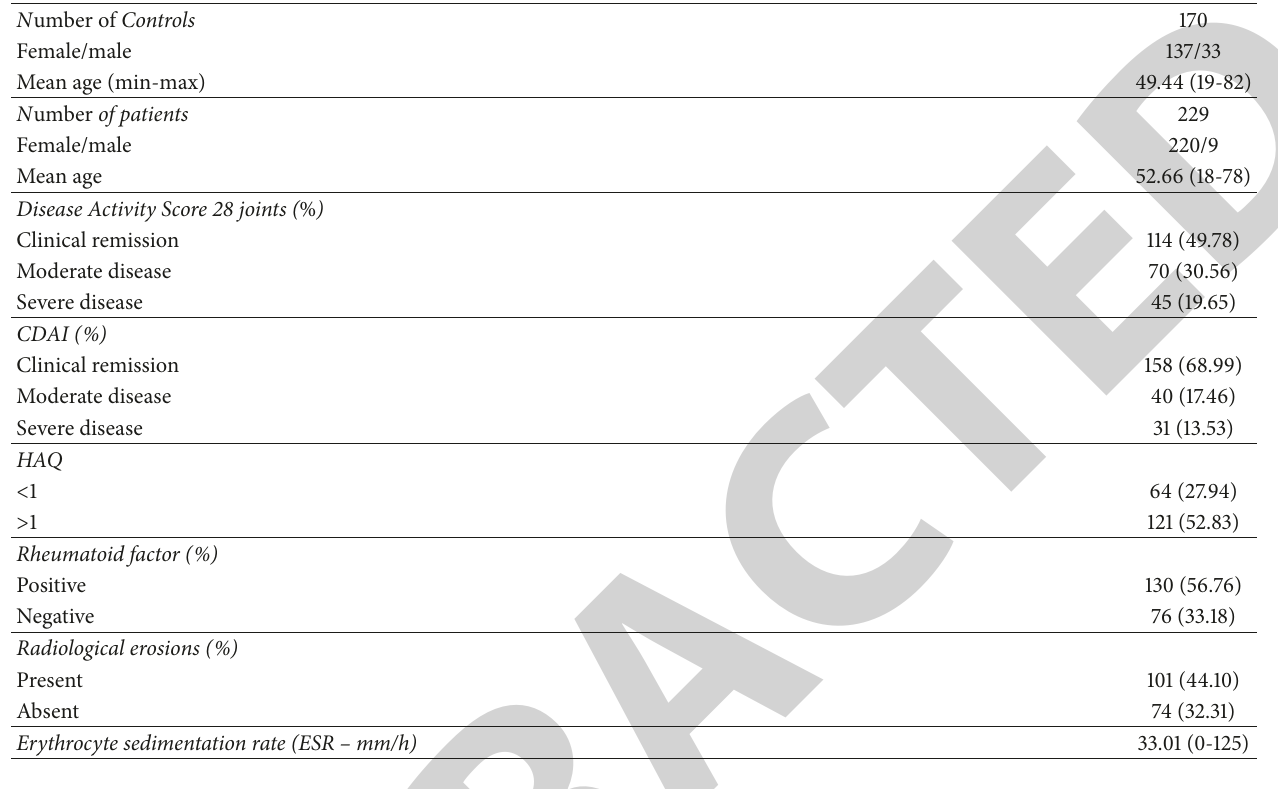
Table 1: Demographic and clinical parameters of RA patients and control